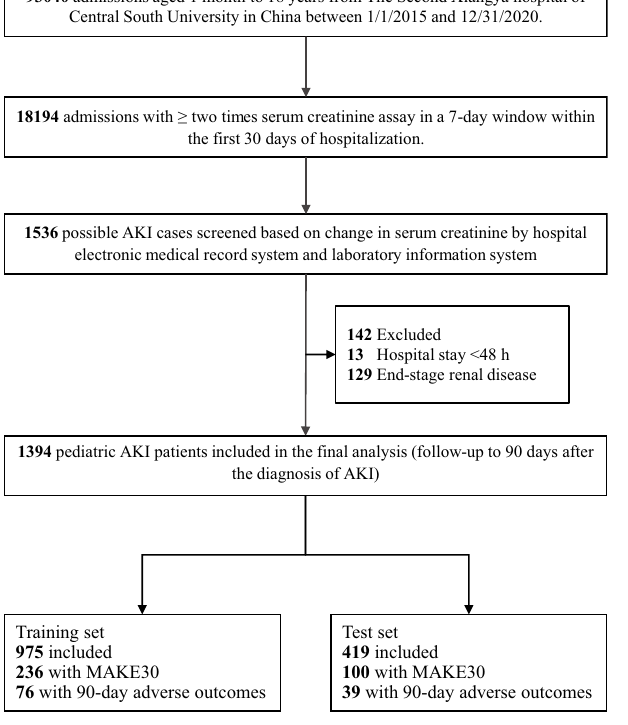
Figure 1. Study flow diagram. AKI, acute kidney injury. MAKE30, Major Adverse Kidney Events within 30 days. The figure was created using Microsoft PowerPoint 2019 (https:// www. micro soft.